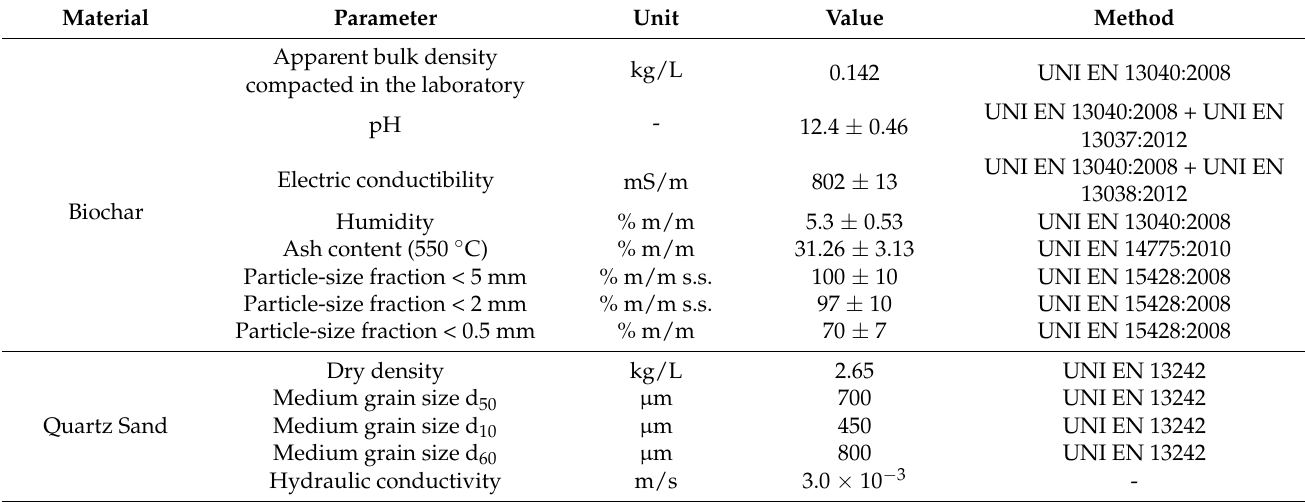
Table 2. Main physical and chemical properties of the biochar and the quartz